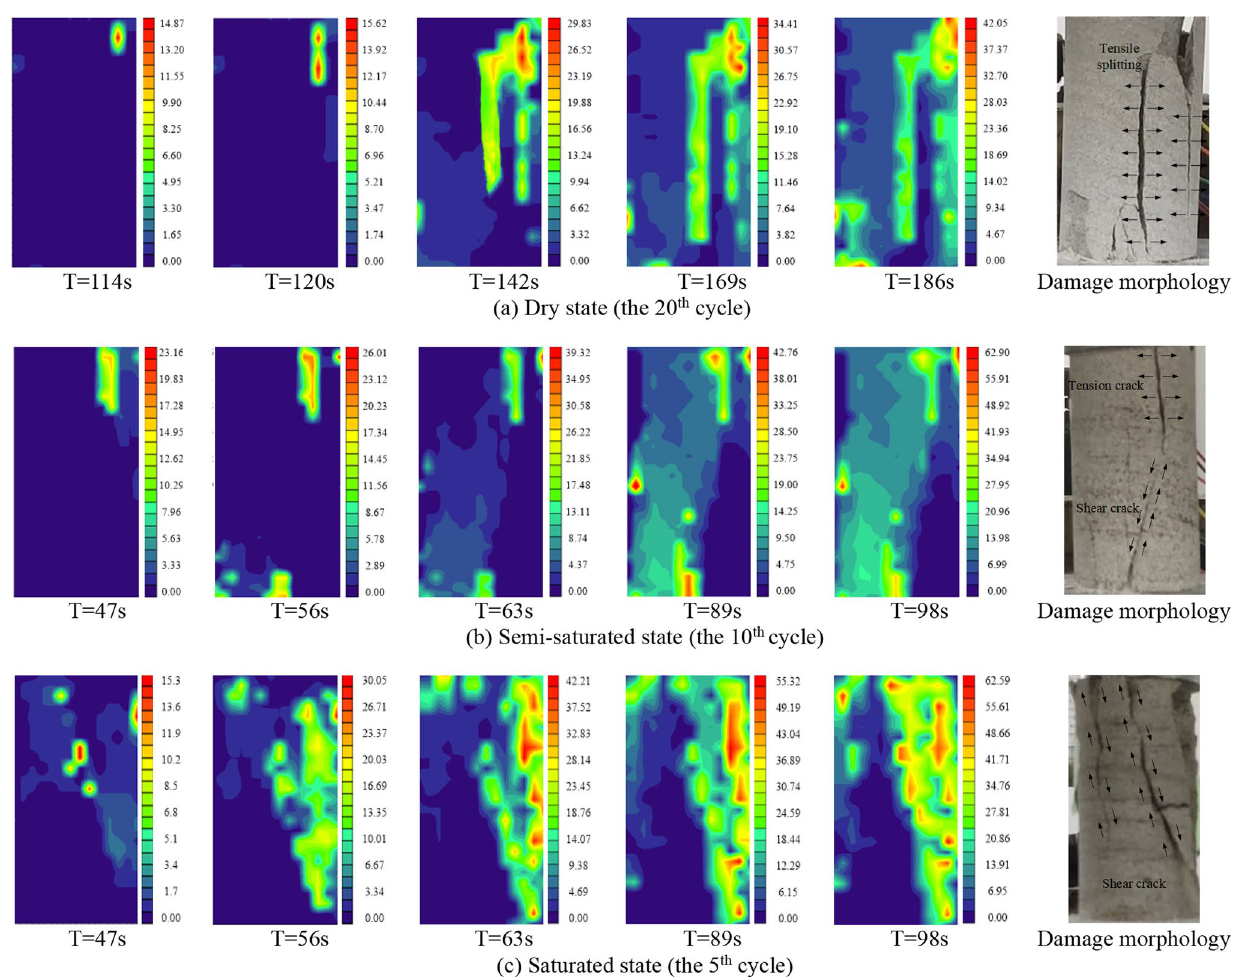
Fig. 14 Cloud maps of sandstone strain field with different water contents under graded cyclic loading–unloading